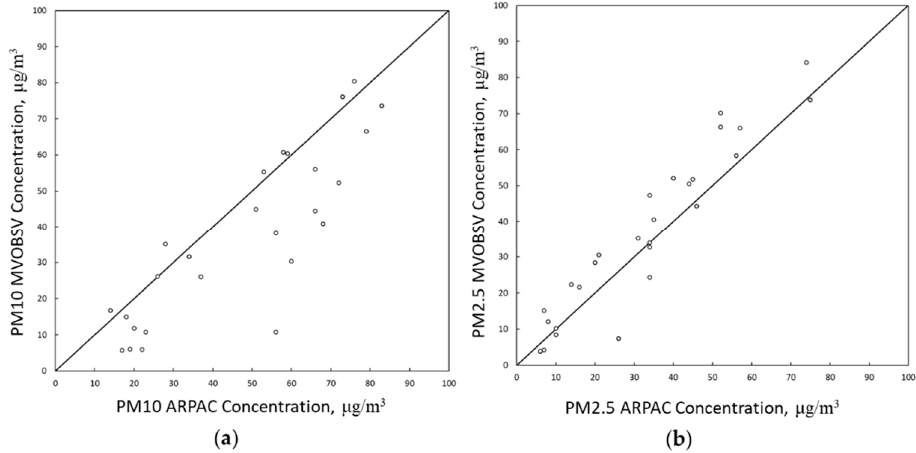
Figure 4. ( a ) Comparison of PM10 daily average concentrations measured at the MV and VC stations. ( b ) Comparison of PM2.5 daily average concentrations measured at the MV and VC stations.